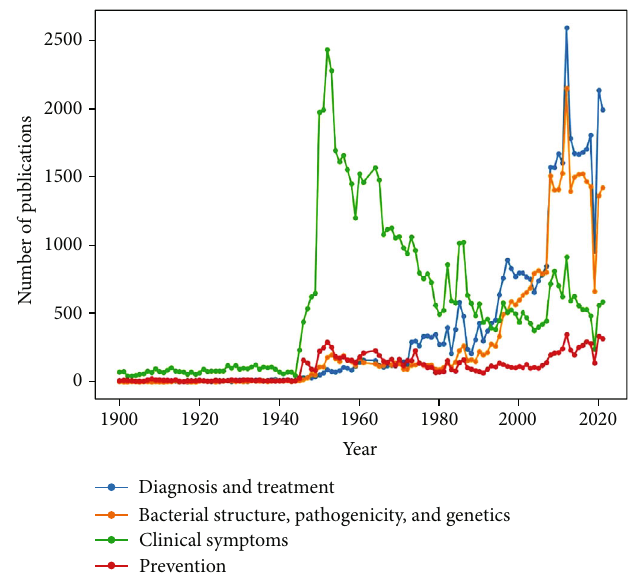
Figure 6: Publishing trend of scienti fi c articles on tuberculosis from 1900 to